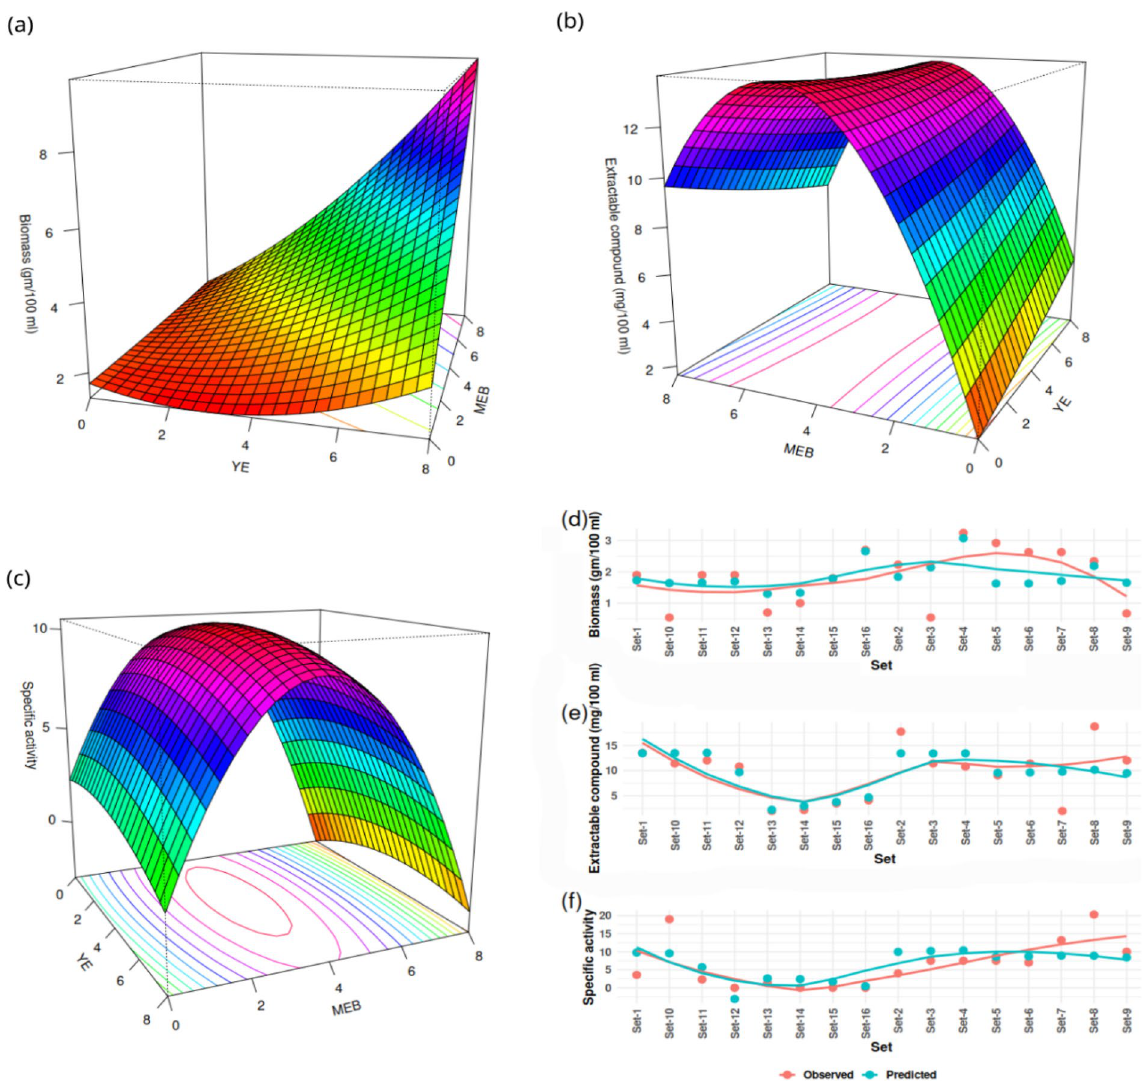
Figure 3. Surface plots ( a – c ) show effects of interaction between MEB and YE on biomass ( a ), extractable compound ( b ), specific activity ( c ). Comparison between predicted values from RSM models for biomass ( d ), extractable compound ( e ) and specific activity ( f ) with observed values are presented in dot plots, and lines are comparing the mean